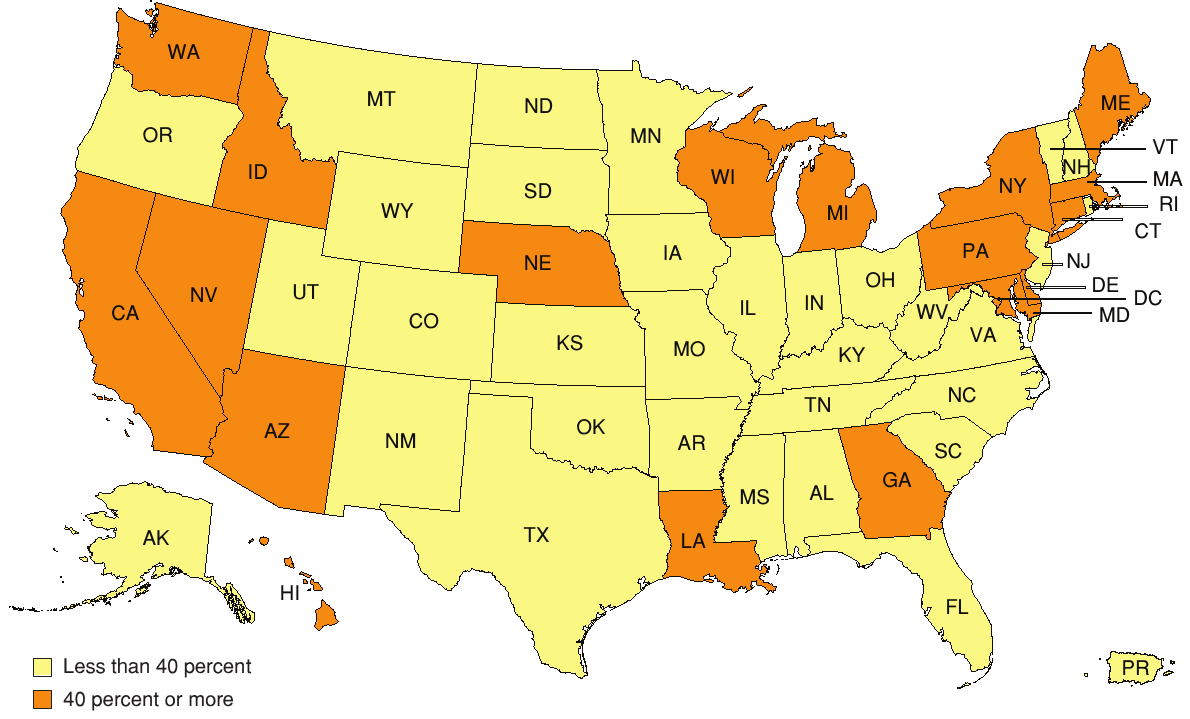
Figure 8. States in which 40 percent or more of all mental health treatment facilities were outpatient mental health facilities: